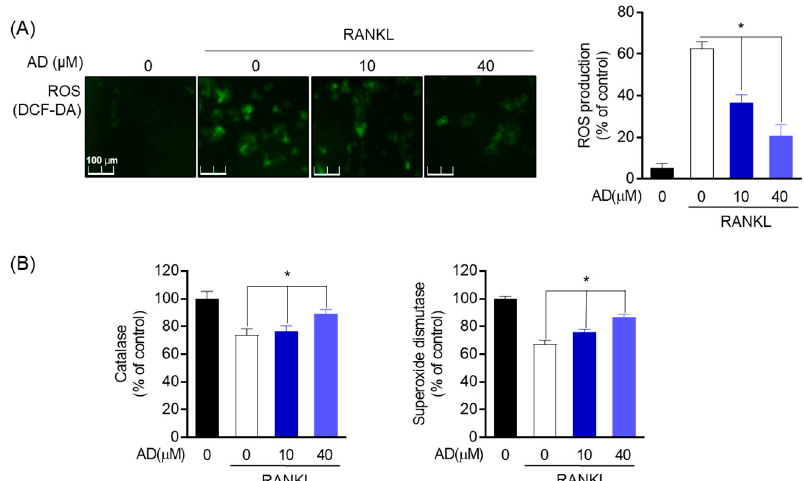
Figure 6. Inhibitory effect of AD on oxidative stress markers in RANKL-induced osteoclasts. ( A ) DCF-DA staining was utilized to detect the RANKL-induced ROS generation in RAW264.7 with different indicated concentrations of AD. ( B ) SOD and CAT activity levels of RAW 264.7 cells pre-treated with AD and stimulated by RANKL (50 ng/mL). * p < 0.05, versus the RANKL-treated group.